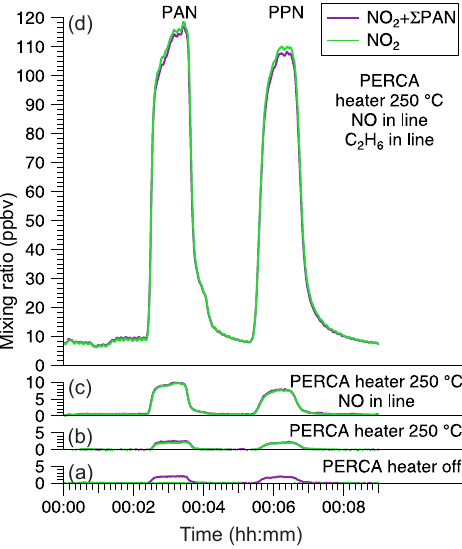
Figure 5. Peroxy radical chemical amplification of peroxyacetic and peroxypropionic nitric anhydride (PAN and PPN) delivered via a megabore GC column. (a) Time series of the signal ob- served by cavity ring-down spectroscopy in the ambient temper- ature (NO 2 ; green) and heated (NO 2 + (cid:54) PAN; purple) channels with the PERCA heater off. (b) Same as (a) with the PERCA heater switched on. (c) Same as (b) with 0.75ppmv NO added. (d) Same as (c) with 1.5% C 2 H 6 added. The amplification factor is determined from the ratio of the ambient temperature (i.e., NO 2 ) CRDS signal observed in (d) divided by that observed in (b) .